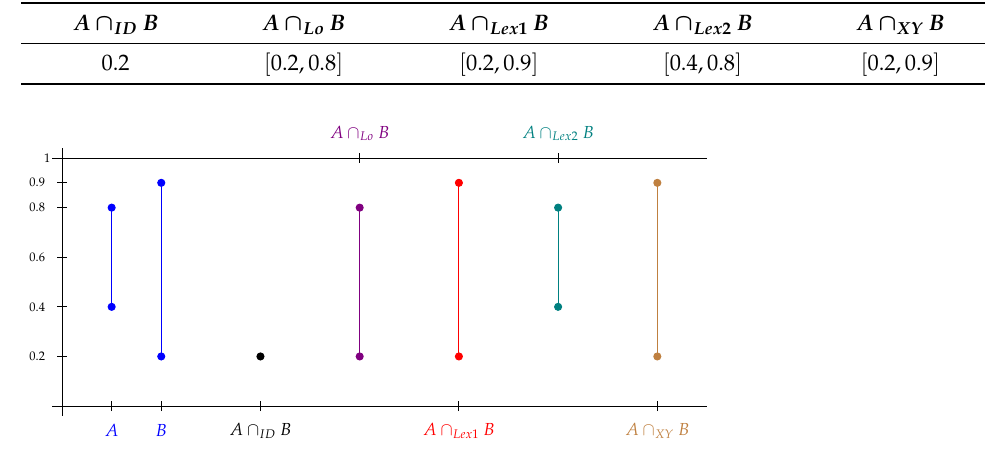
Figure 7. Intersection w.r.t. ID , Lo , Lex 1, Lex 2 and XY